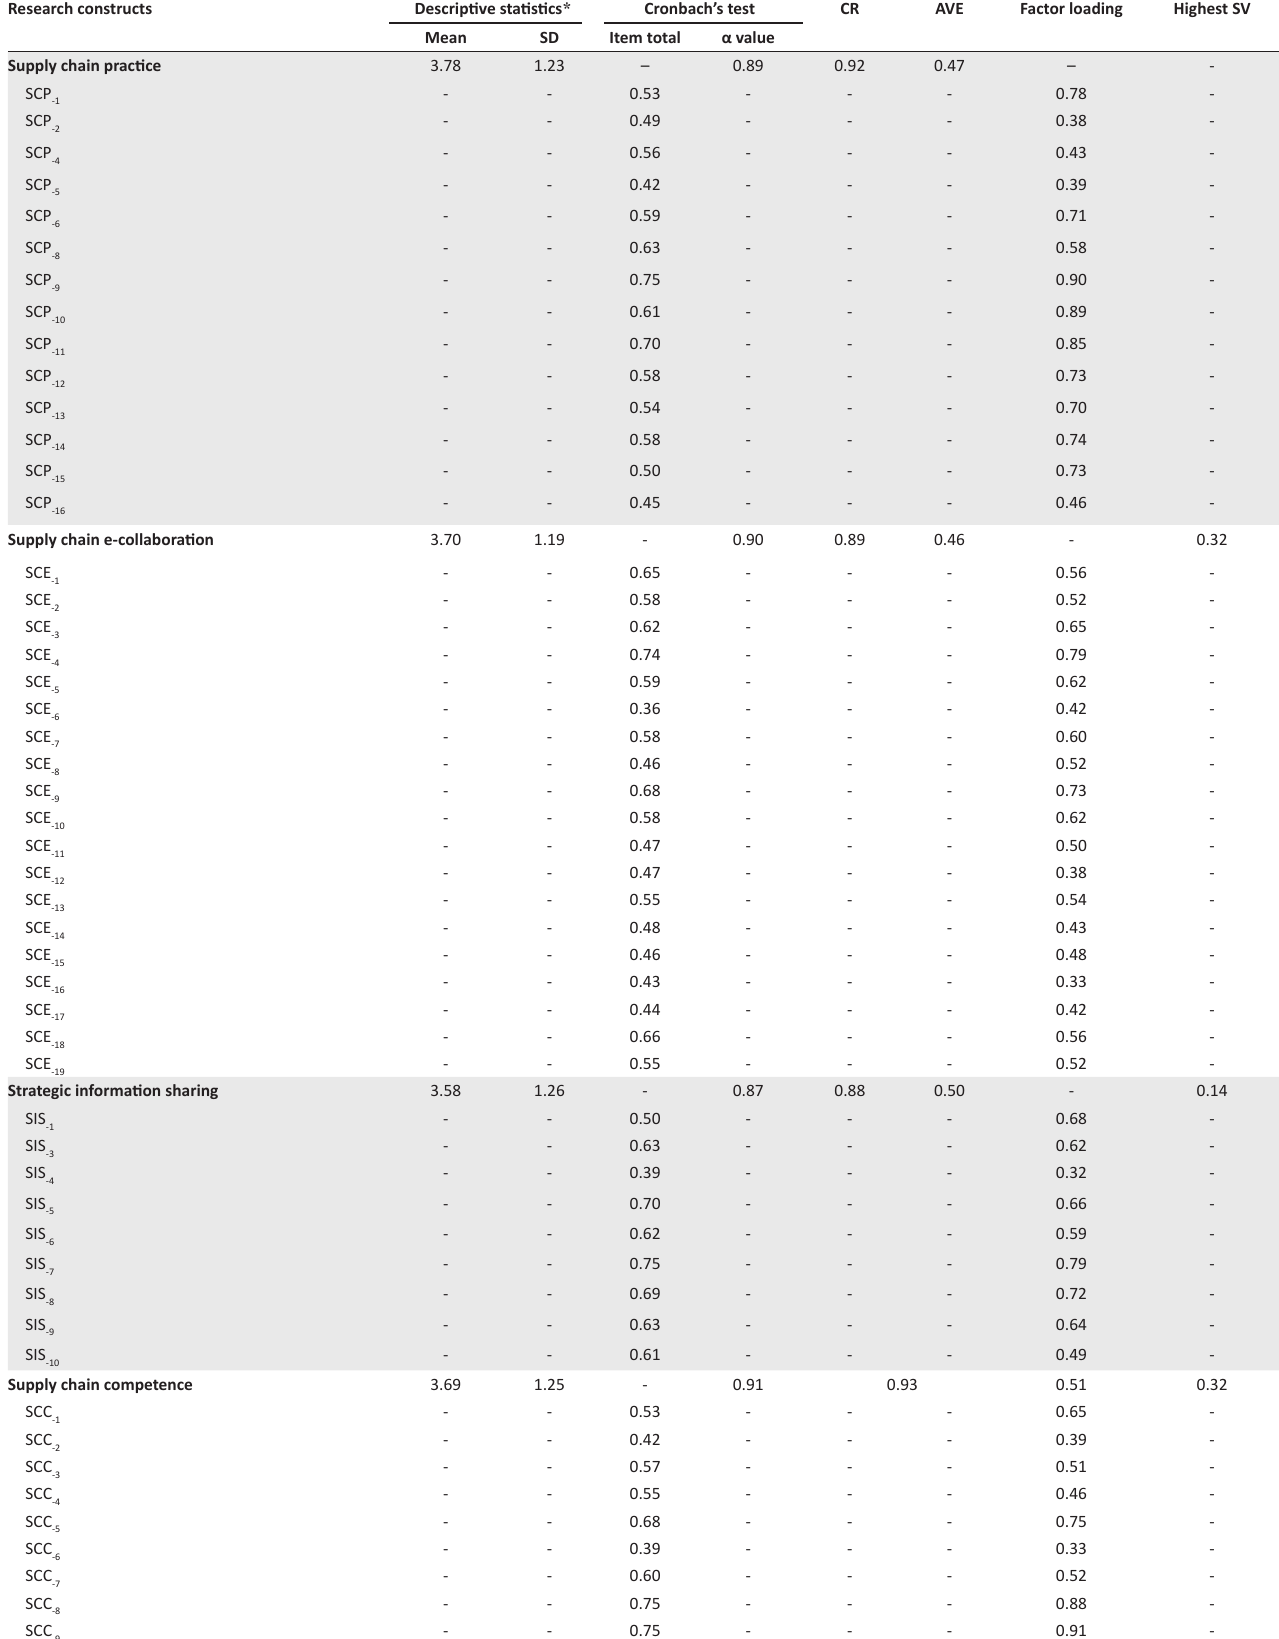
TABLE 2: Accuracy analysis statistics: Reliability